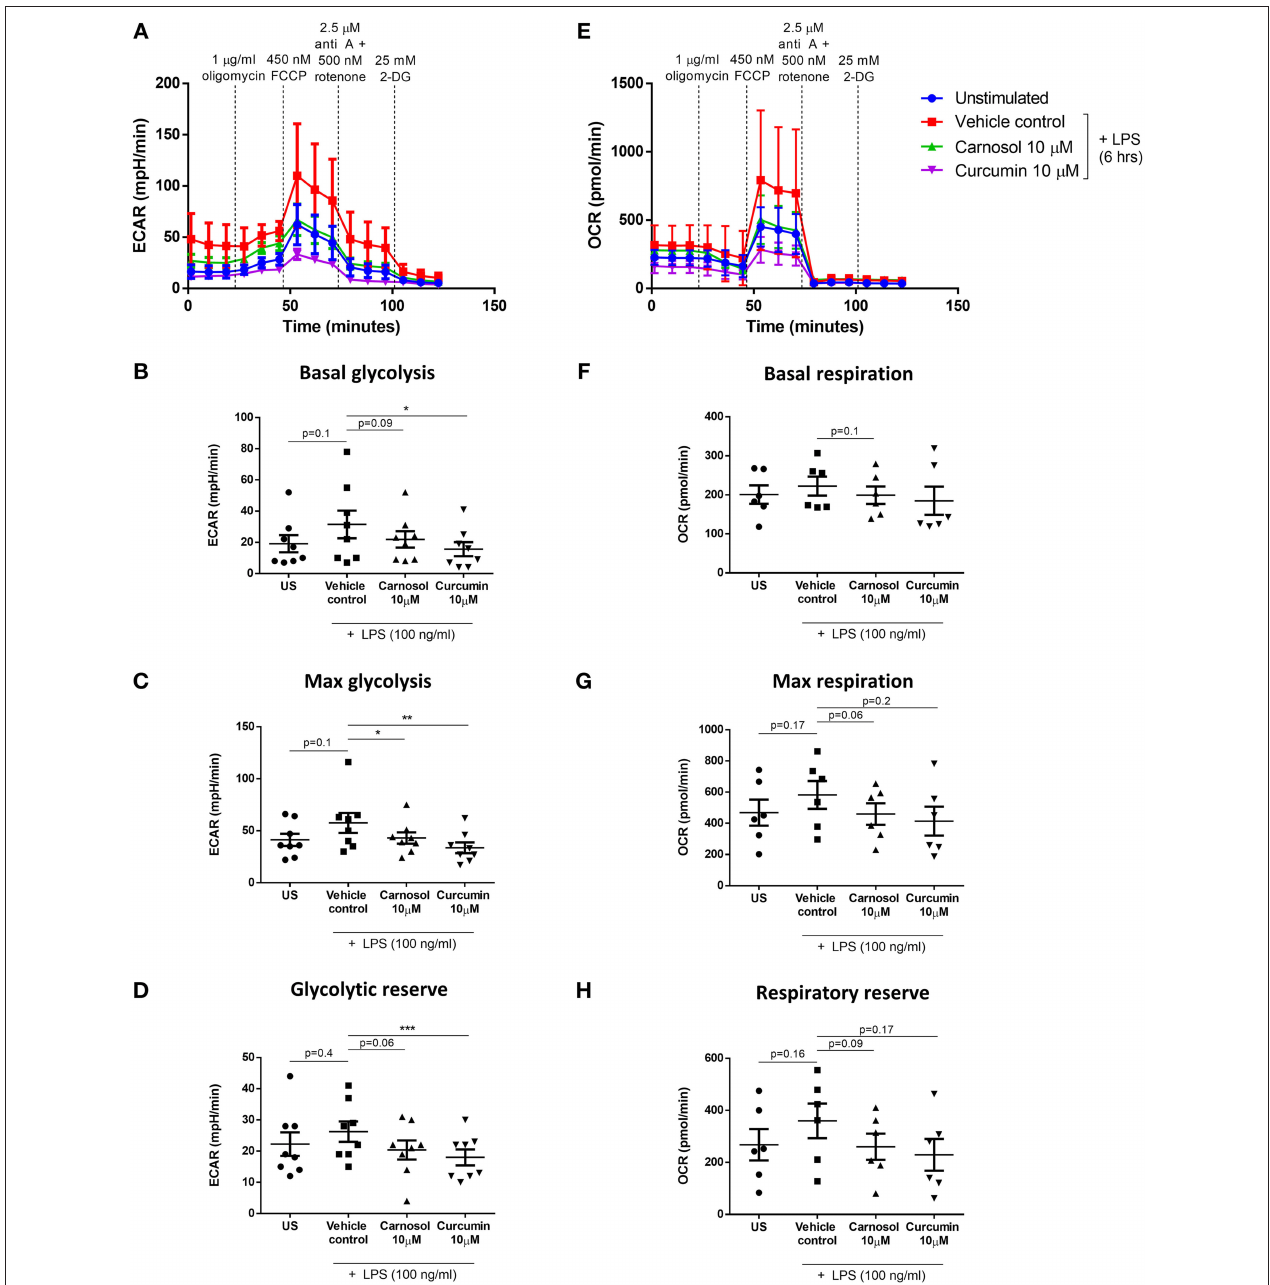
FIGURE 2 | Carnosol and curcumin reduce the upregulation of glycolysis and spare respiratory capacity of LPS-stimulated DC. Primary human DC were either left unstimulated (US), or treated with carnosol (10 µ M), curcumin (10 µ M) or a vehicle control for 6h, then stimulated with LPS (100ng/ml) for 6h prior to placement in a Seahorse XFe24 analyser. The extracellular acidification rate (ECAR) and the oxygen consumption rate (OCR) were measured before and after the addition of oligomycin (1 µ g/ml), FCCP (450nM), antimycin A (2.5 µ M), and rotenone (500nM), and 2-DG (25mM). (A) ECAR measurements over time for each treatment group. Data depicts one representative experiment. Pooled data ( n = 8) depicts the calculated mean ( ± SEM) (B) basal glycolytic rate, (C) max glycolytic rate and (D) glycolytic reserve for each treatment group. (E) OCR measurements over time for each treatment group. Data depicts one representative experiment. Pooled data ( n = 6) depicts the calculated mean ( ± SEM) (F) basal respiratory rate, (G) max respiratory rate, and (H) respiratory reserve for each treatment group. Statistical significance was determined by repeated measures one-way ANOVA with Dunnett’s multiple comparisons post hoc test to compare treatment groups against the control group (*** p < 0.001, ** p < 0.01, * p < 0.05).